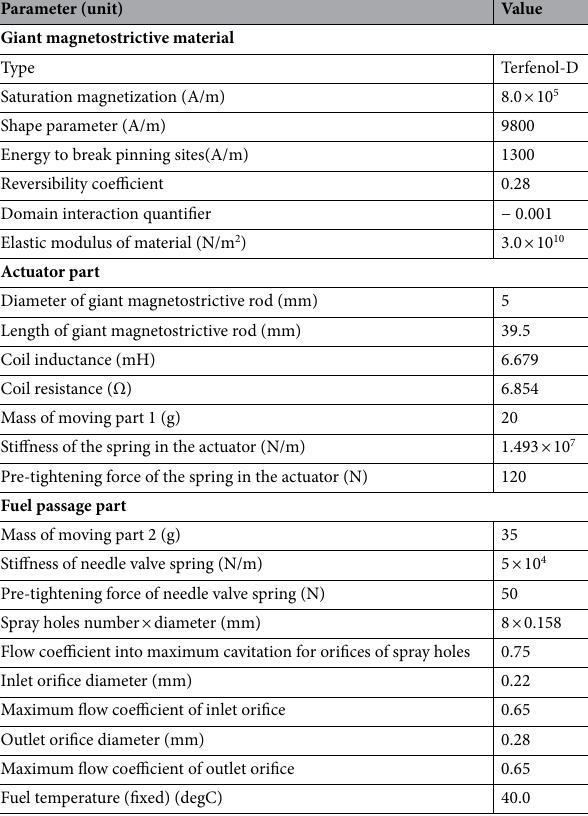
Table 1. Key parameters of the GMI.